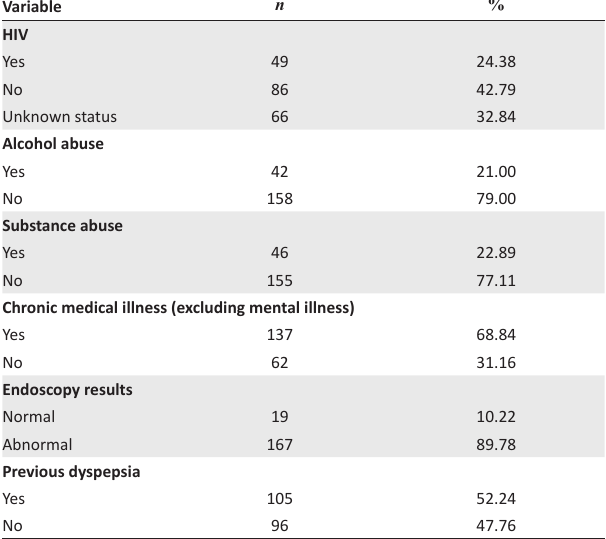
TABLE 2: Clinical profiles.